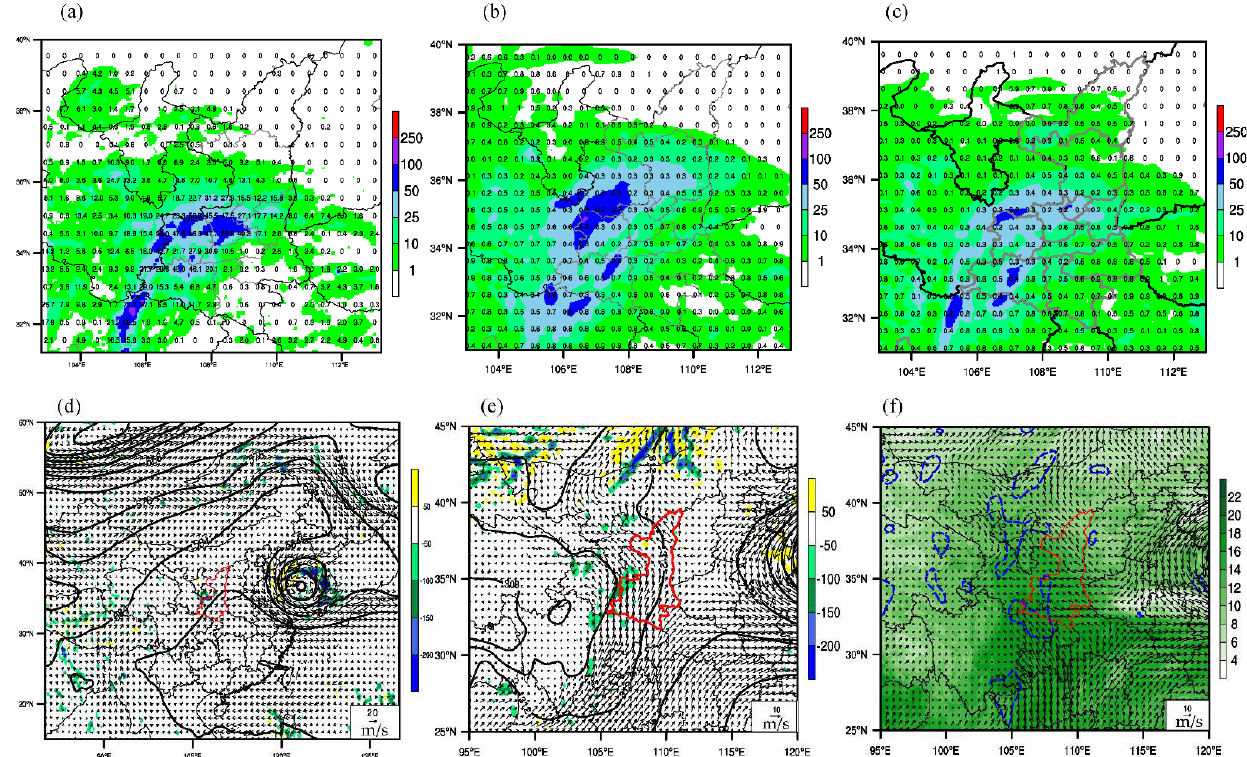
Figure 5. The CMPA precipitation of a rainstorm forecast case on 23 July and the precipitation and high−altitude situation forecast of ECMWF model corresponding to the observation period. ( a ) and high − altitude situation forecast of ECMWF model corresponding to the observation CMPA 24 h cumulative precipitation from 00 UTC on 23 July to 00 UTC on 24 July. ( b ) The ECMWF model accumulated precipitation from 00 UTC on 23 July to 00 UTC on 24 July, and the initial time was 00 UTC on 22 July. ( c ) Same as ( b ), but the initial time was 12 UTC on 22 July. ( d ) The geopo- tential height of 500 hPa, the vertical velocity and wind field of the ECMWF model at 12 UTC on 23 July, and the initial time was 00 UTC on 22 July. ( e ) Same as ( d ), but for 700 hPa. ( f ) Same as ( d ), but it is 850 hPa specific humidity, relative divergence and wind field.